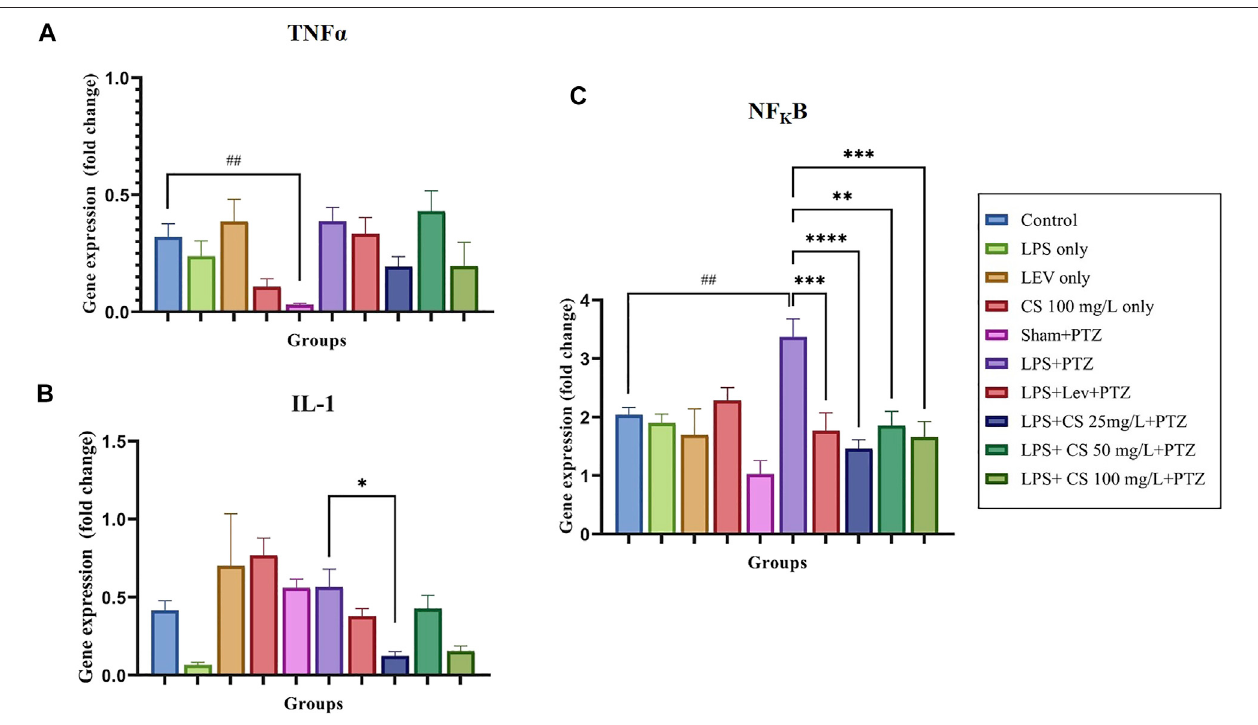
FIGURE4| Geneexpressionlevelsforthefollowingin fl ammatorygenes: (A) TNF α , (B) NF K B,and (C) IL1.The p -values**** p < 0.0001,*** p < 0.001,** p < 0.01,and * p < 0.05 were regarded as statistically signi fi cant for the treatment groups compared to the negative control (LPS + PTZ). The p -values #### p < 0.0001, ### p < 0.001, ## p < 0.01 and # p < 0.05 was regarded as statistically signi fi cant for the per se groups compared to the control.